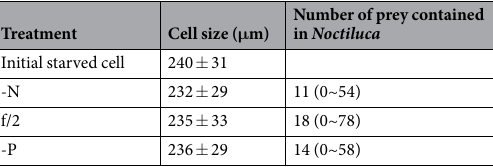
Table 2. Cell diameters of Noctiluca scintillans ( µ m, mean ± SD) and the number of prey held in Noctiluca cells (averages with the range in parenthesis) after 1d incubation with N-limited (-N), nutrient-balanced (f/2) and P-limited (-P) Thalassiosira weissflogii